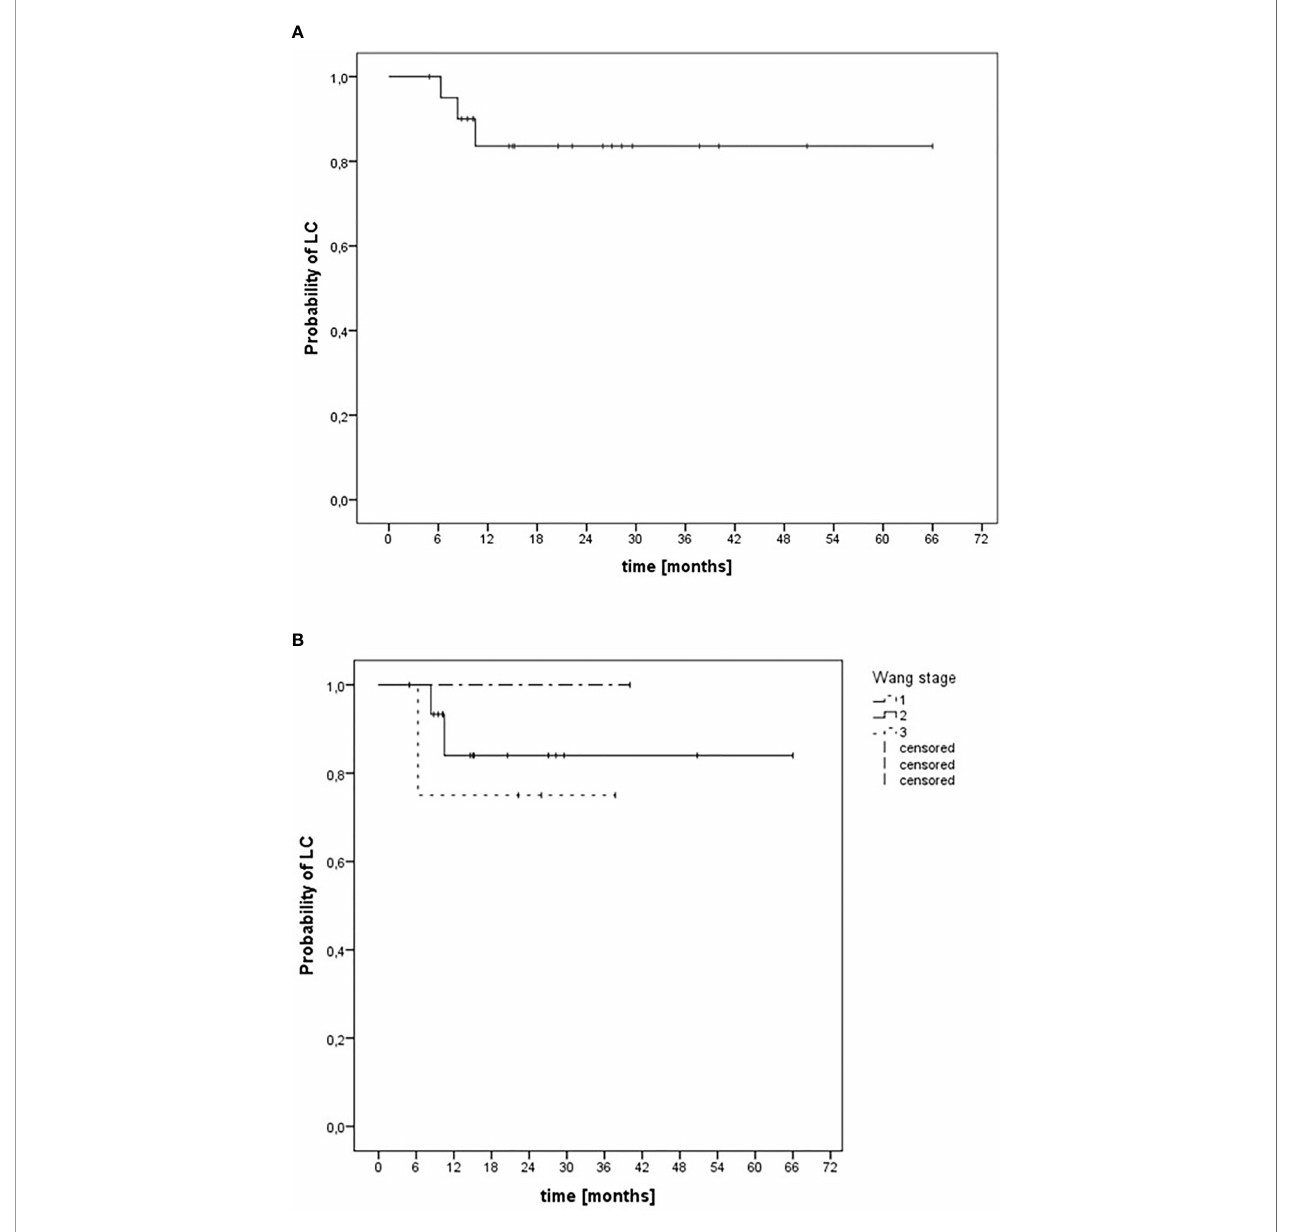
FIGURE 2 | Kaplan – Meier estimation of local control after de fi nitive radiotherapy of 21 patients with malignant tumors involving the nasal vestibule irradiated with CIRT-B combined with VMAT. (A) LC independent of tumor stage. (B) LC depending on Wang